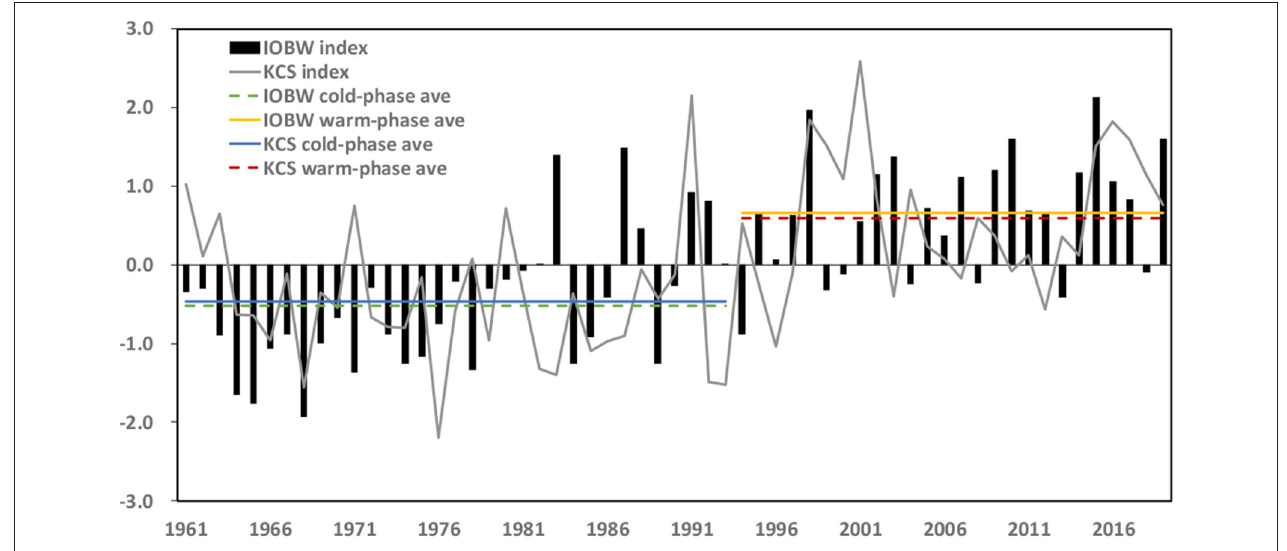
FIGURE 7 | Regression of 500 the hPa geopotential height against the IOBW index in early summer during (A) the cold period and (B) the warm period (dotted areas indicate the 95% significance level), and (C) difference of 500-hPa geopotential height (unit: gpm) between warm and cold periods calculated by linear regression.